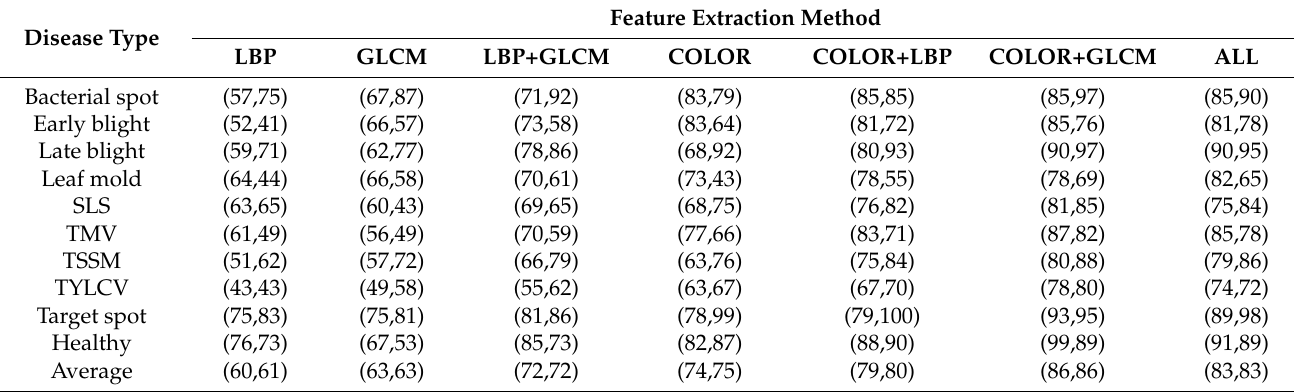
Table 2. Results for different feature extraction methods with the kNN classifier; results are displayed as tuples (precision percentage and recall percentage) with two significant digits.